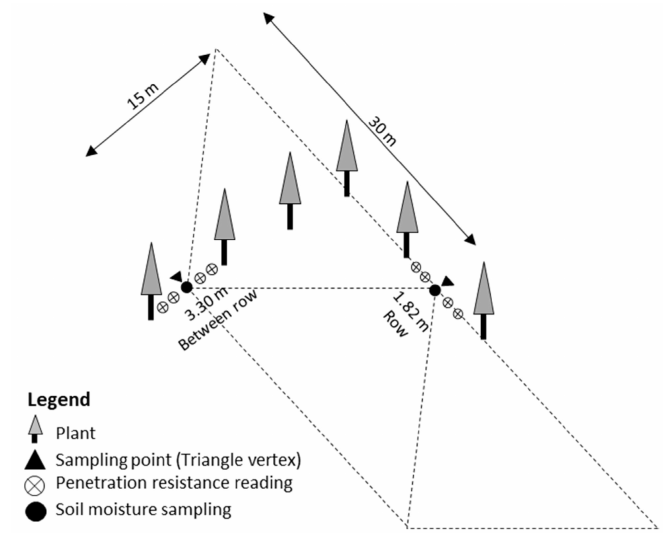
Figure 2. Sampling scheme for penetration resistance (PR) and soil moisture in coppicing and stand renewed with different straw levels 100, 50 and 0% areas, both preceded by eucalyptus harvest with Harvester + Forwarder (HF) and Feller + Skidder (FS). Sampling points are defined by the vertices of isosceles triangles (15 m of height and 30 m of